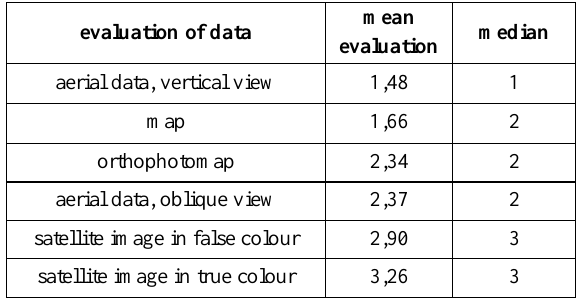
Table 8. Subjective evaluation of images and